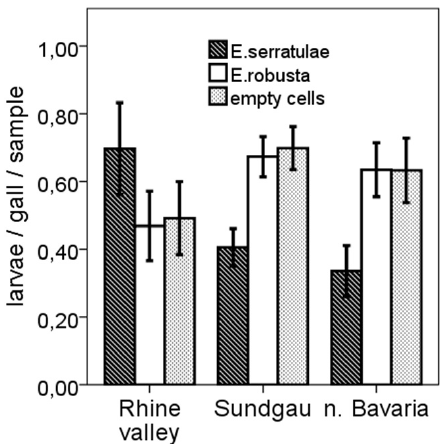
Figure 8. Parasitization of U. cardui samples by E. serratulae and E .robusta in 3 different regions of western Europe. Sundgau (France, region of Belfort): 307 samples, 6463 galls (1970– 2004); Upper Rhine Valley ( region n.w. Freiburg): 78 samples, 1885 galls (1972–1992); North eastern Bavaria (region s.e. Bayreuth): 216 samples, 4131 galls E. serratulae and E. robusta: regional differences The parasitization rates of E. serratulae and E. robusta vary temporally and locally with the population dynamics of U. cardui (Zwölfer et al. 2007). These fluctuations are superimposed by regional differences (Fig. 8). Examples are the U. cardui populations in the floodplain forests of the upper Rhine Valley, where the host occurs in relatively stable source-sink systems. In these forests the average density / gall / sample of E. ser- ratulae (mean = 0.744, SE = +0.069 was distinctly higher than that of E. robusta (mean = 0.427, SE = +0.052). In northern Bavaria (Bayreuth – Pegnitz) U. cardui occurs in a fragmented, agriculturally influenced landscape in mostly short-living population sys- tems and metapopulations. Here E. robusta dominated with a mean density of 0.661, SE = +0.04 over E. serratulae (mean = 0.364, SE = +0.043). The Belfort-Sundgau region holds an intermediate position ( E. serratulae : mean = 0.459, SE = +0.031. Eury- toma robusta : mean = 0.638, SE = +0.027). If our whole material collected in western and central Europe ( E. serratulae = 772 gall samples, E. robusta = 755 gall samples) is compared, the average mortality of U. cardui due to E. robusta plus the empty cell fac- tor ( = 38.9%) is more than twice as high as that of E. serratulae (14.8%).